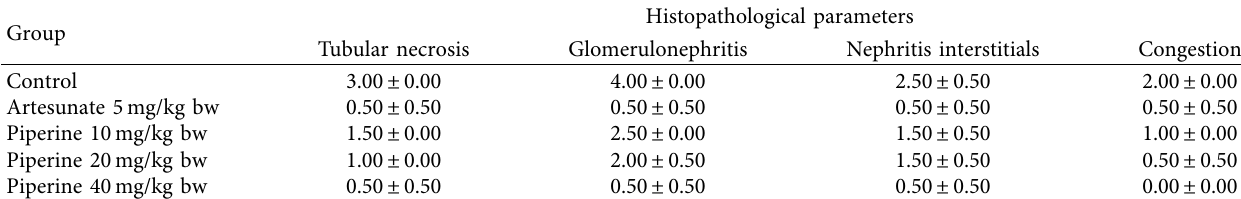
Table 4: Semiquantitative analysis of kidney histopathology in the curative test.